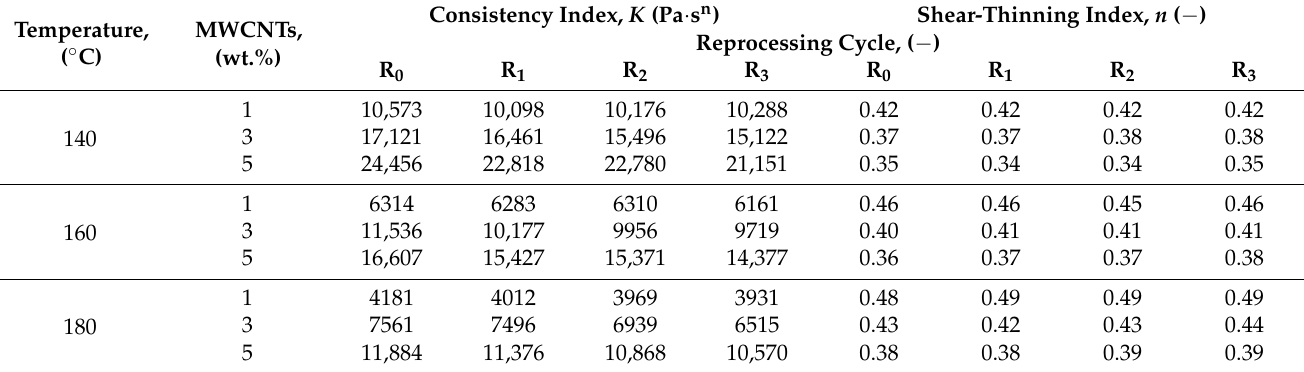
Table 2. The consistency and shear-thinning index for the EVA/MWCNT